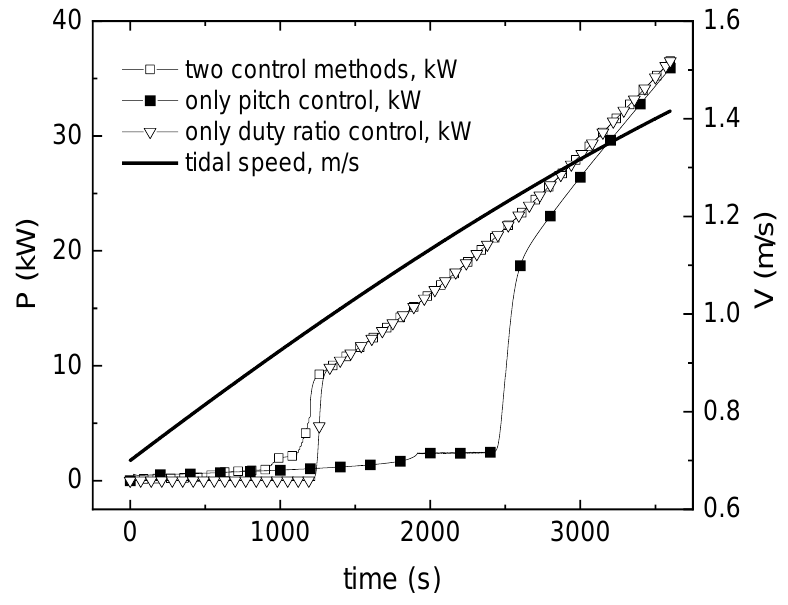
Figure 9. Control results in the low flow rate stage.